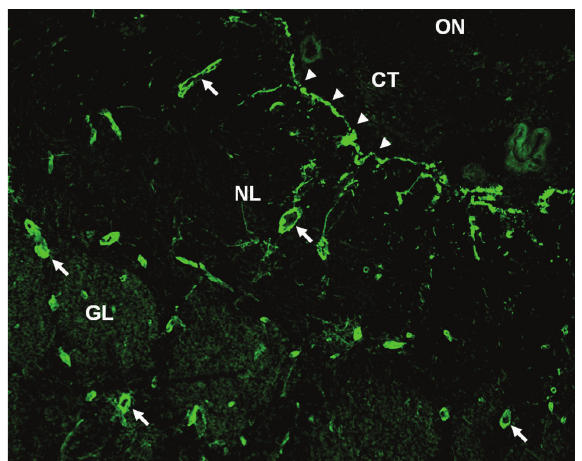
Figure 1: Binding of serum NMO-IgG to the olfactory bulb as demonstrated by indirect immunohistochemistry on formalin-fixed rat tissue cryosections. Binding of the patient’s IgG is shown in green (AF488). See method section for details. The figure shows a transverse section through the right olfactory bulb near the medial surface. Arrowheads = pia mater; arrows = microvasculature; GL = olfactory glomeruli; ON = peripheral olfactory nerves (ON); NL = nerve fibre layer; CT = connective tissue next to the medial surface of the olfactory bulb.